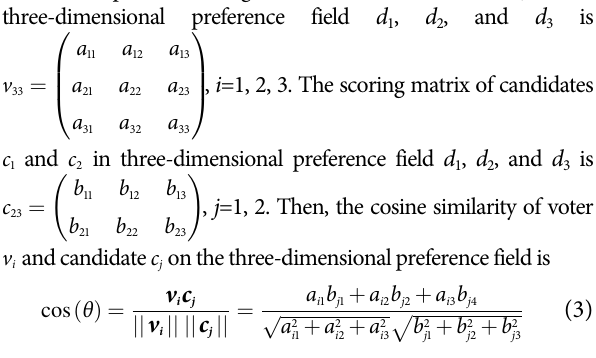
Fig. 1. Each candidate is represented by a three-dimensional vector, whose dimensions are the candidate ’ s field, strength in that field, and propensity (direction). For each voter, a preference matrix is used to record his or her score for the field. For example, ’ s score for Field 1 is A voter V . 1 11